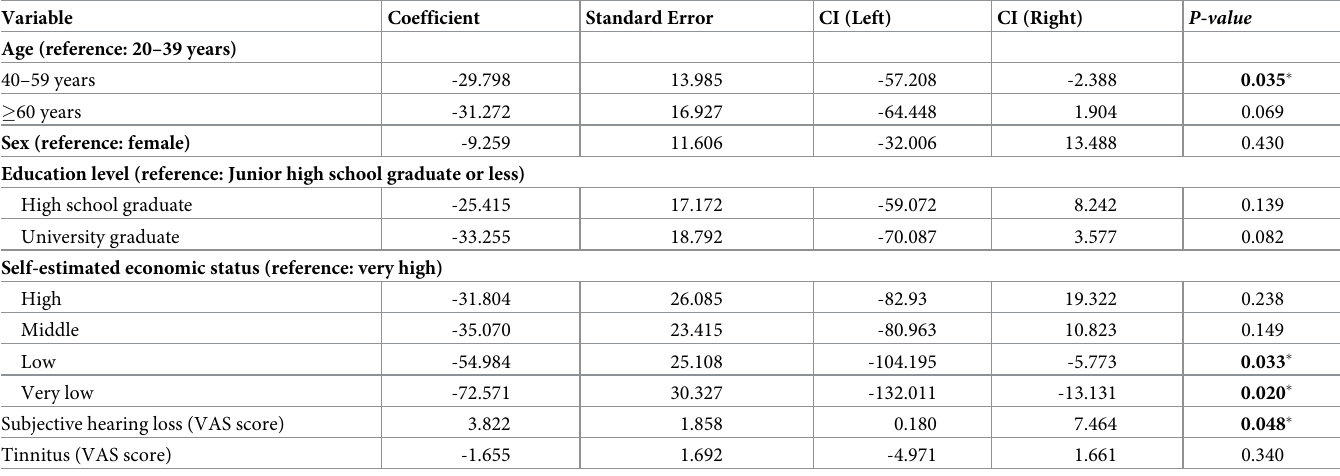
Table 4. Factors affecting the expected price of personal sound amplification